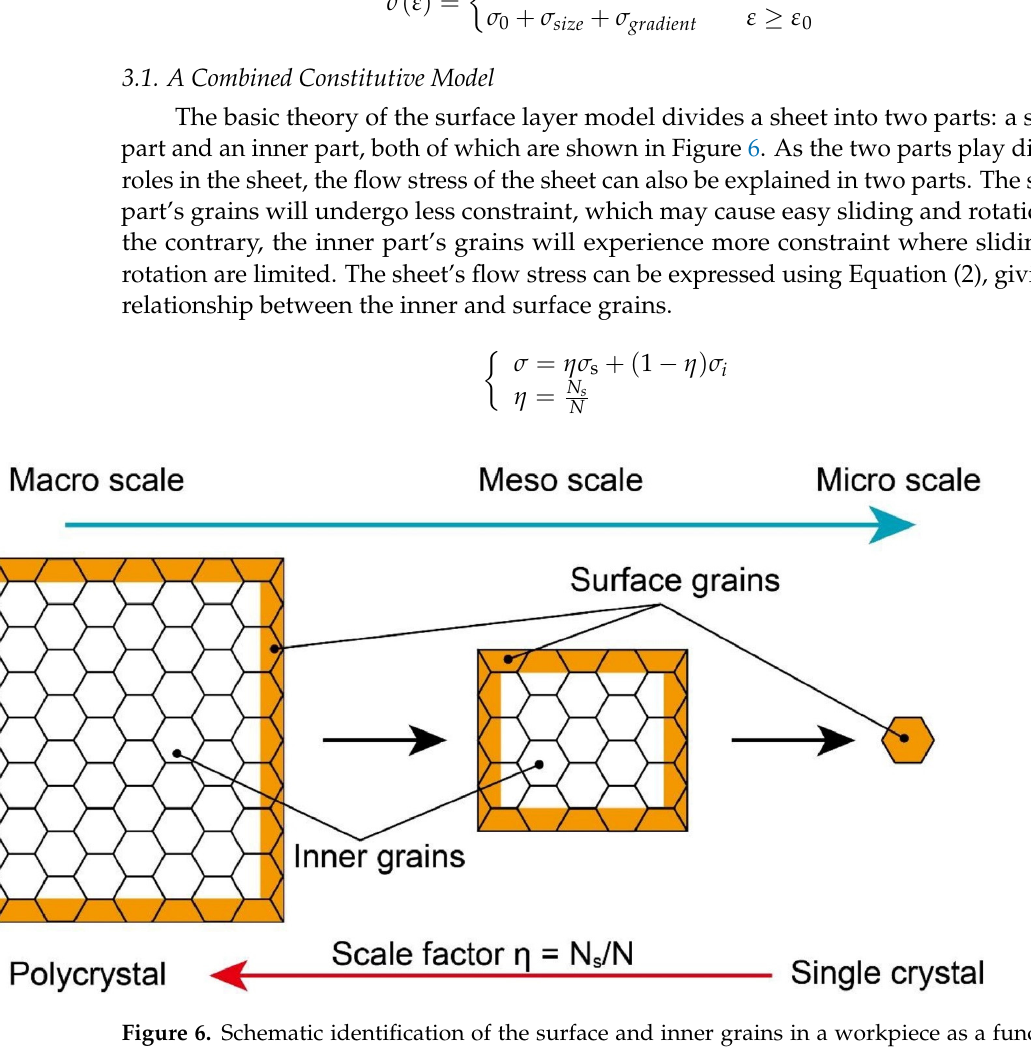
Figure 6. Schematic identification of the surface and inner grains in a workpiece as a function of overall scale [30].